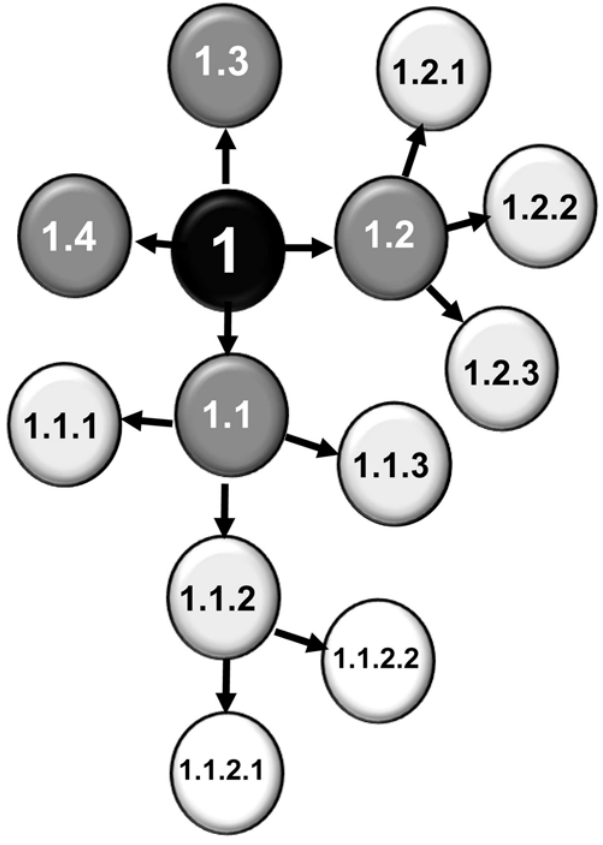
Figure 2. A ‘division tree’ diagram showing the growth and division of yeast cells from a single original mother cell. The original mother cell is labelled ‘‘1’’. Each time a new bud (daughter) appeared on the original mother cell it was labelled 1.1, 1.2, 1.3 etc…and the time of appearance noted. When these daughter cells produced buds they were labelled 1.1.1, 1.1.2 etc… Two sets of data could be derived: a) the successive time taken for a cell to divide multiple times (mother cell reproduction times), and b) the time taken from emergence as a bud on a mother cell to subsequent first division (daughter cell reproduction Table 1 ). Gamma cell lifetime distributions were fitted using maximum likelihood, to [ PSI + ] and [ psi 2 ] data sets separately and combined ( Table 3 ). Using a likelihood ratio test, no significant difference in cell lifetime distributions for [ PSI + ] and [ psi 2 ] cells was observed.